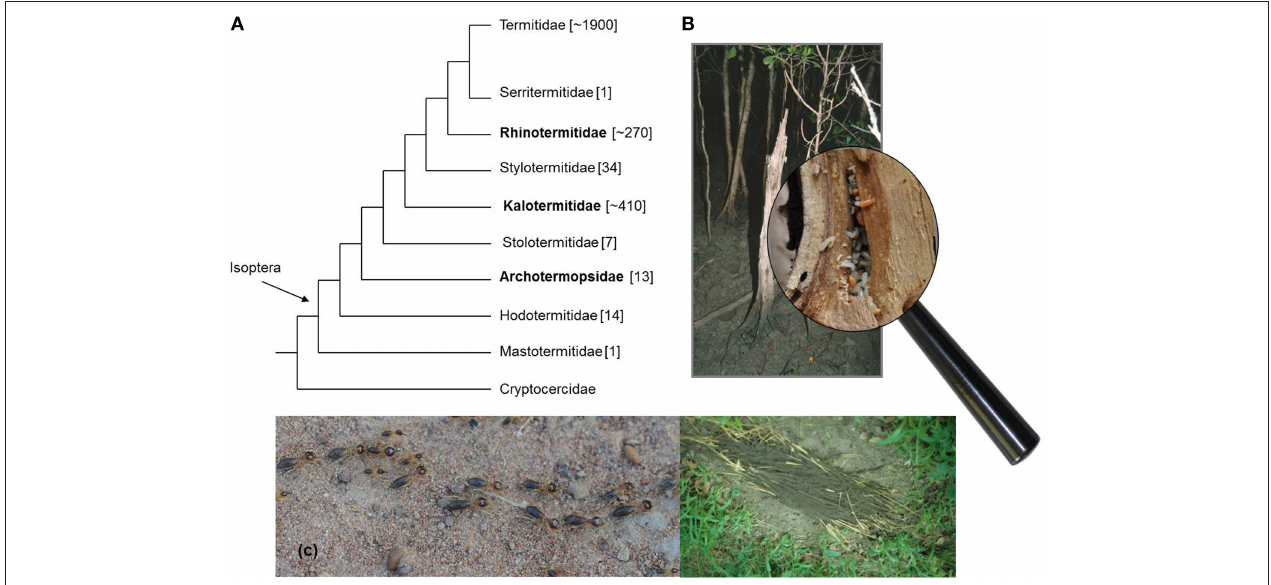
FIGURE 1 | Termite diversity. (A) Cladogram of termite families with the Cryptocercidae (woodroaches) as sister-taxon. Families with a wood-dwelling life type (one-piece nester) are in bold . Note the Rhinotermitidae have both life types. (B) Wood-dwelling termites like C. secundus nest in a piece of wood (often a dead tree) that serves both as food and shelter. (C) The fast majority of recent termites belong to the separate pieces life type. Here, workers and soldiers leave the nest (below or above ground) to forage outside for food outside. Shown are foraging Trinervitermes and a food source covered with soil sheeting exploited by Macrotermes bellicosus